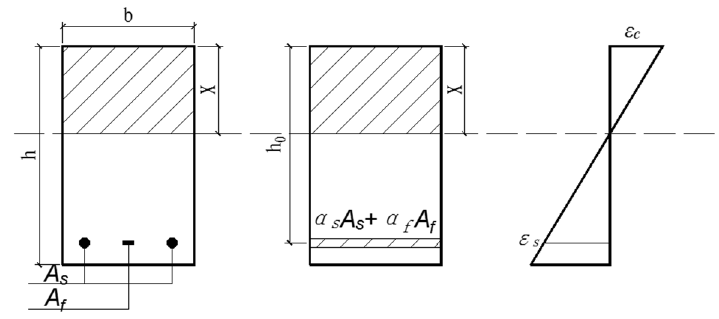
Figure 9. Schematic diagram of conversion section.